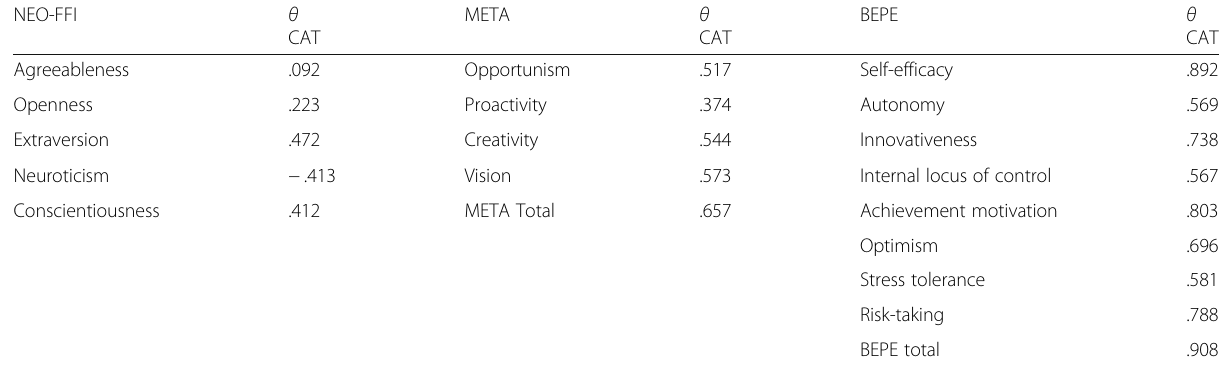
Table 3 Pearson correlations between θ CAT scores and BEPE, META, and NEO-FFI tests NEO-FFI θ META CAT